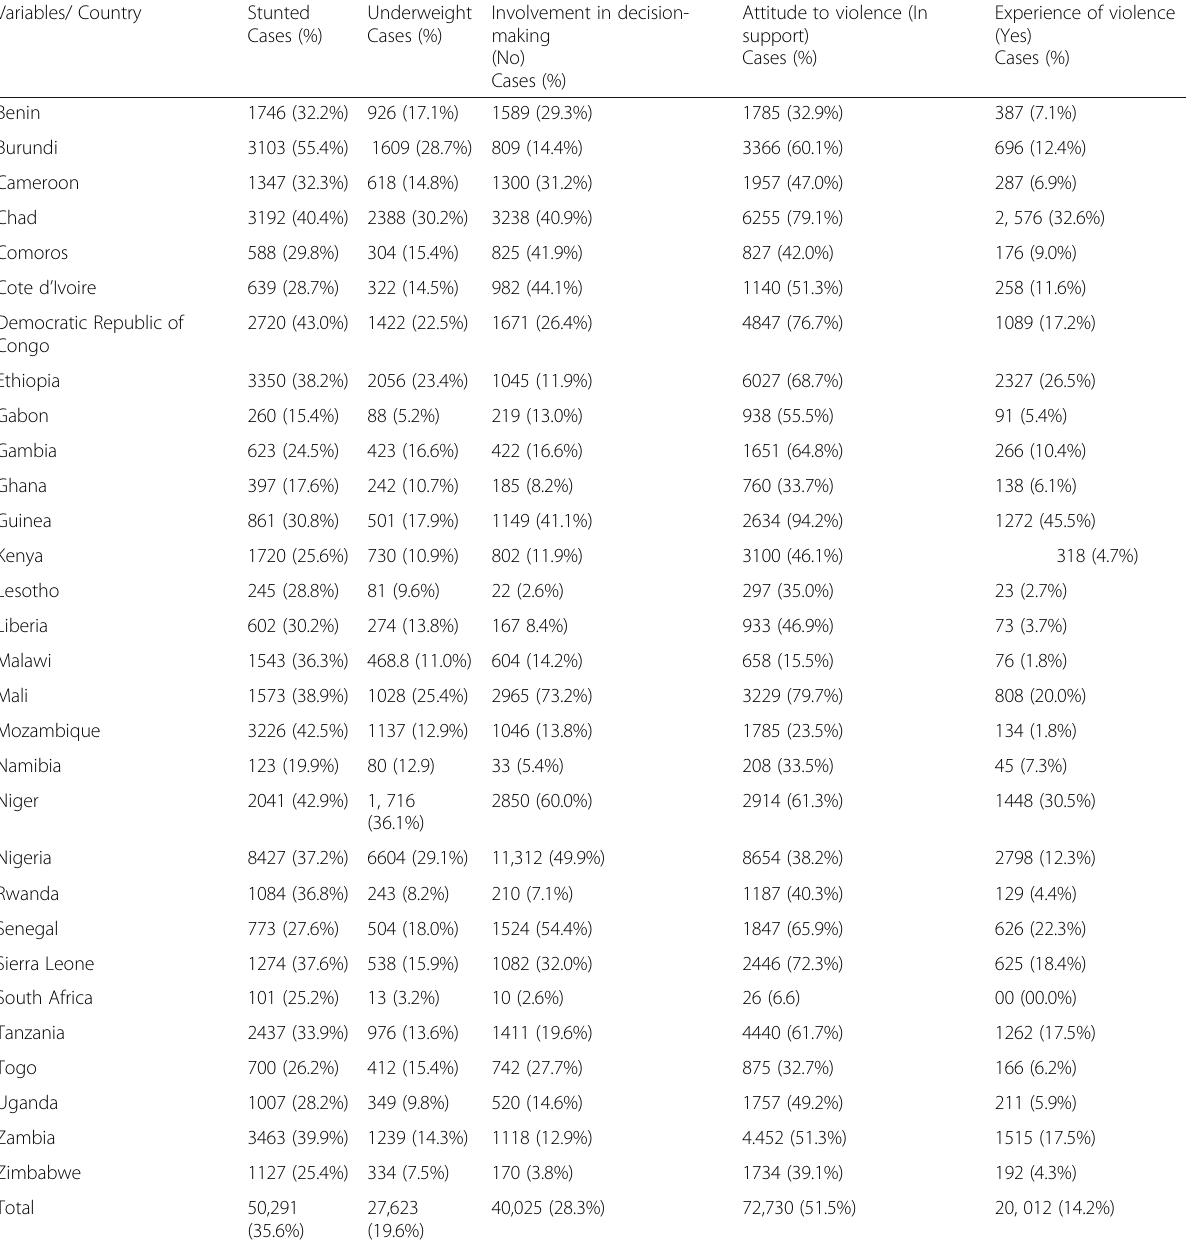
Table 2 Women ’ s empowerment and nutritional status by